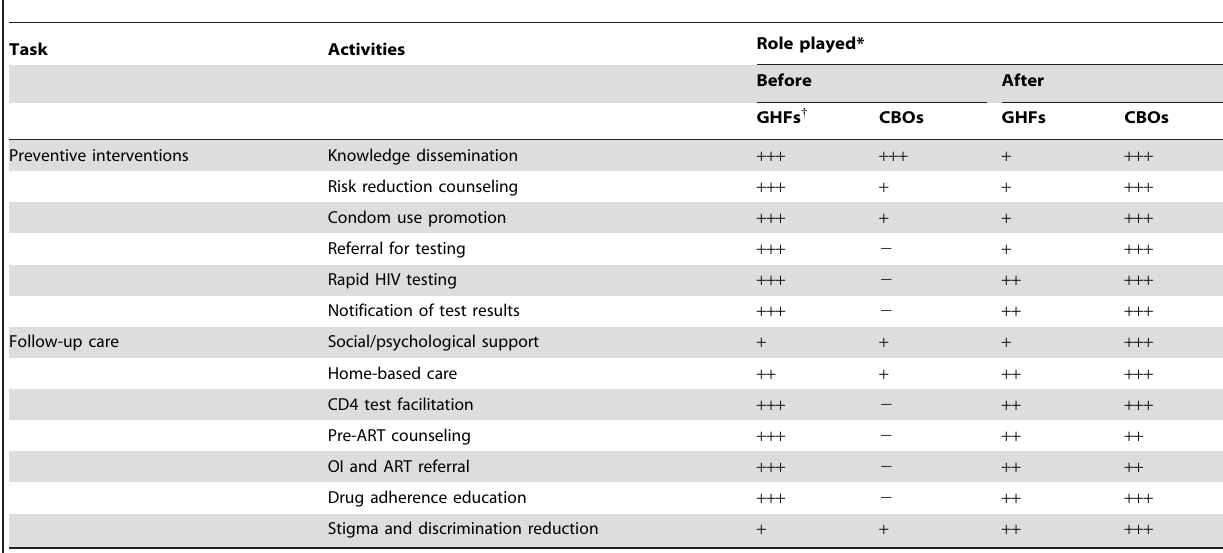
Table 1. Roles of community-based organizations (CBOs) and government health facilities (GHFs) in the tasks before and after the pilot program in Nanjing, China.